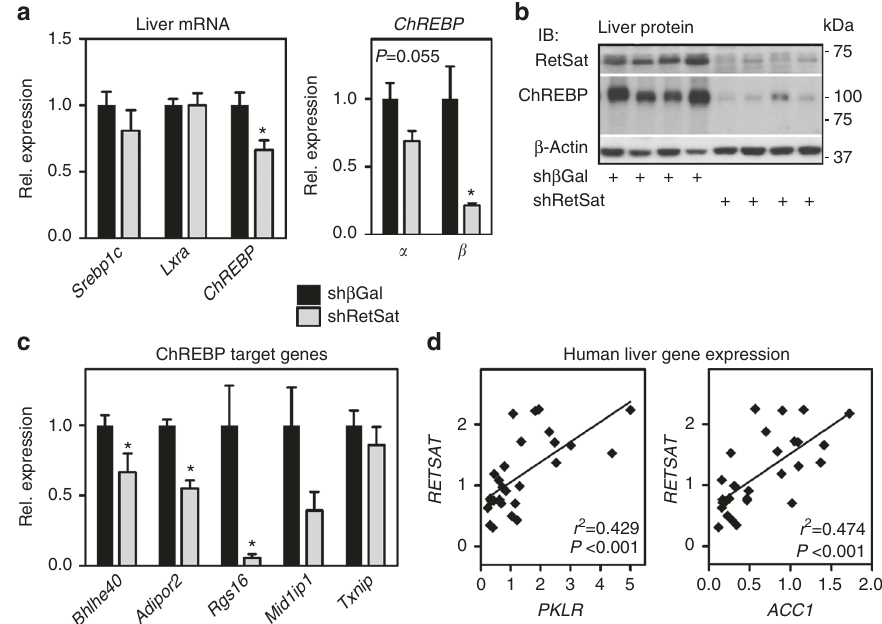
Fig. 4 RetSat depletion in mouse liver reduces protein levels and target gene expression of ChREBP. Mice fed HS/HFD were injected with adenoviruses expressing shRNA targeting β Gal or RetSat. Six days later, livers were analyzed for a mRNA expression of the indicated transcription factors. b RetSat and ChREBP protein expression by immunoblotting, and c known ChREBP target genes by qPCR. In a , c , data are shown as mean ± s.e.m., n = 7 (sh β Gal), 6 (shRetSat); * P < 0.05 by two-tailed t -test. d RETSAT, PKLR and ACC1 mRNA expression in human liver samples was determined by qPCR ( n = 29) and correlated. Normality of data were tested by the Kolmogorov – Smirnov test and signi fi cance was determined by the Pearson correlation coef fi